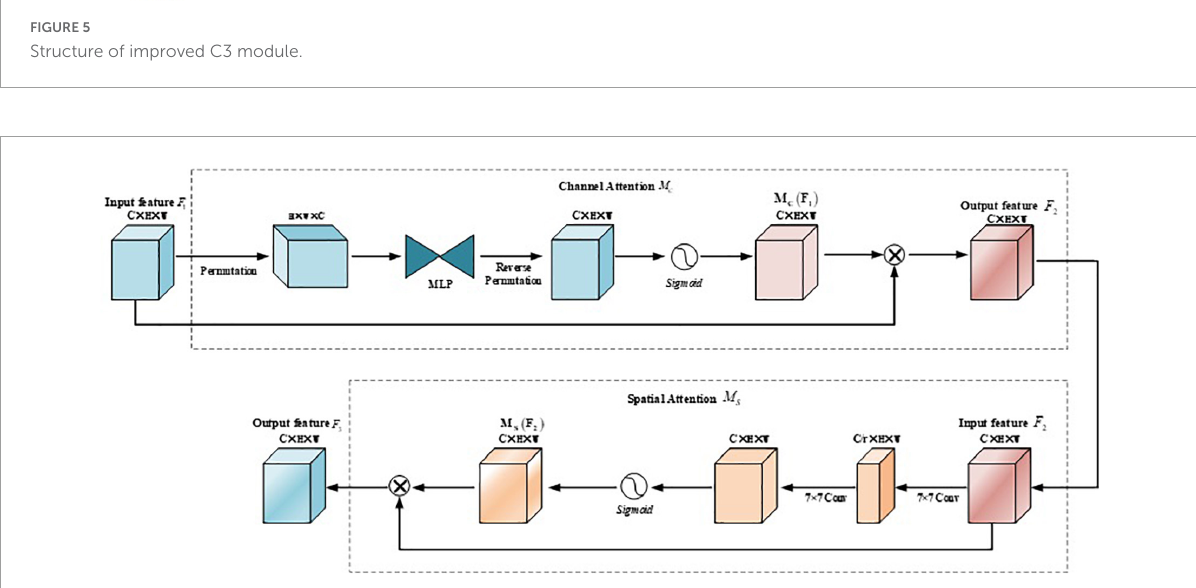
FIGURE6 Structure of global attention mechanism (GAM) module.